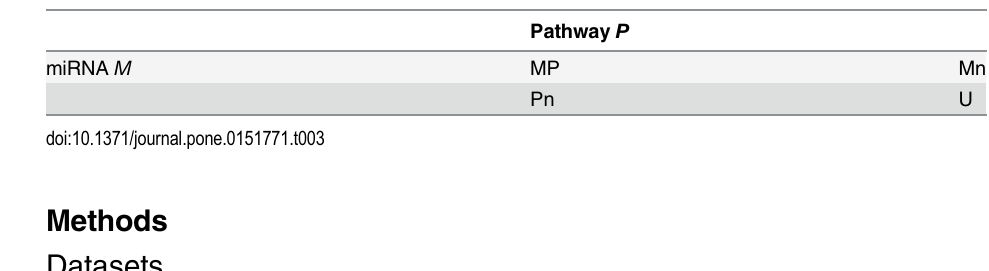
Table 3. 2x2 cross table.